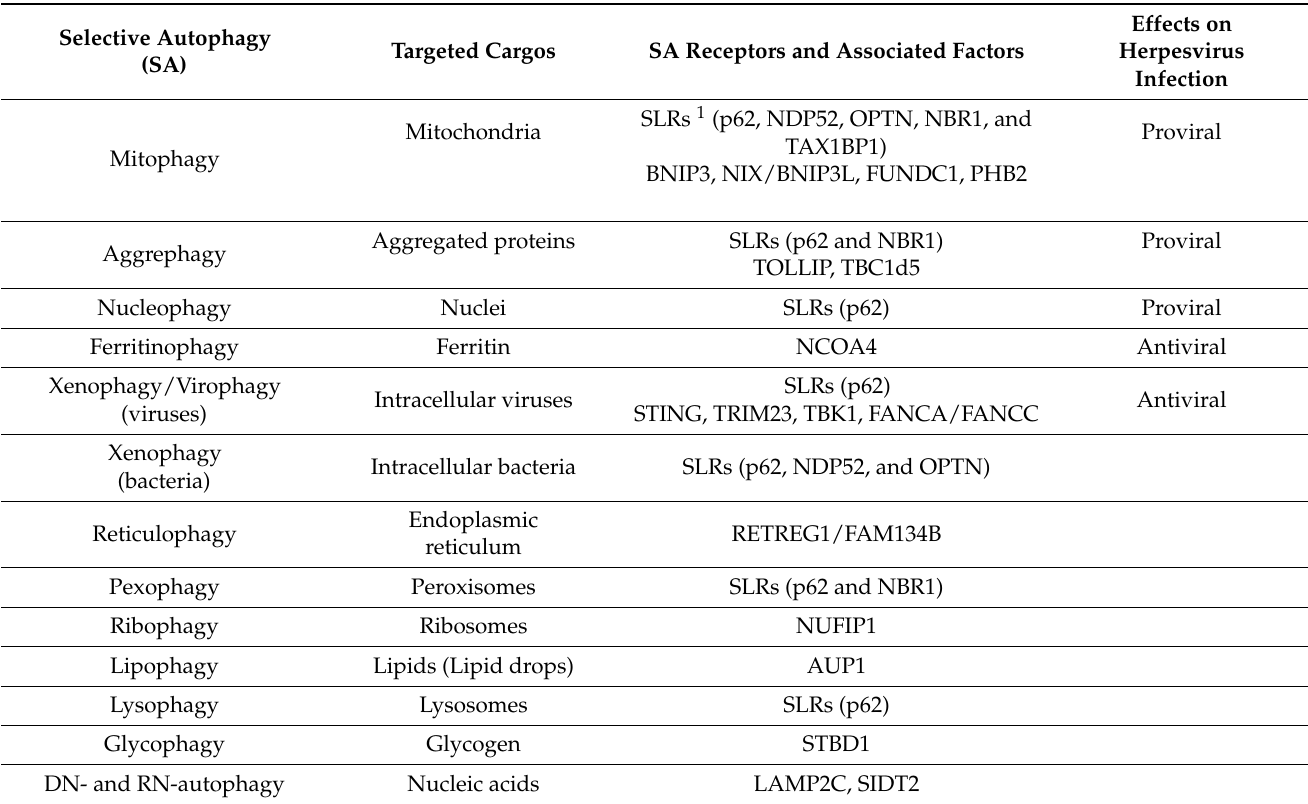
Table 1. Selective autophagy and